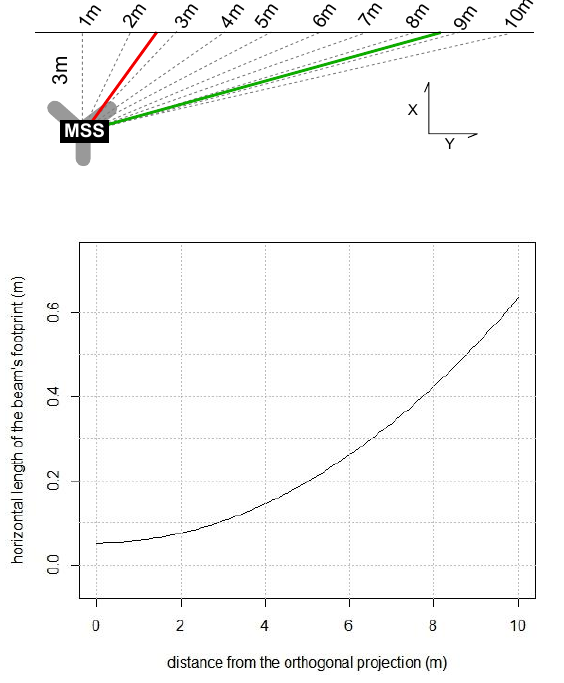
Figure 5: Top-view of the theoretical acquisition setup (top); Es- timation of the SONAR horizontal resolution as a function the distance from the orthogonal projection (bottom)